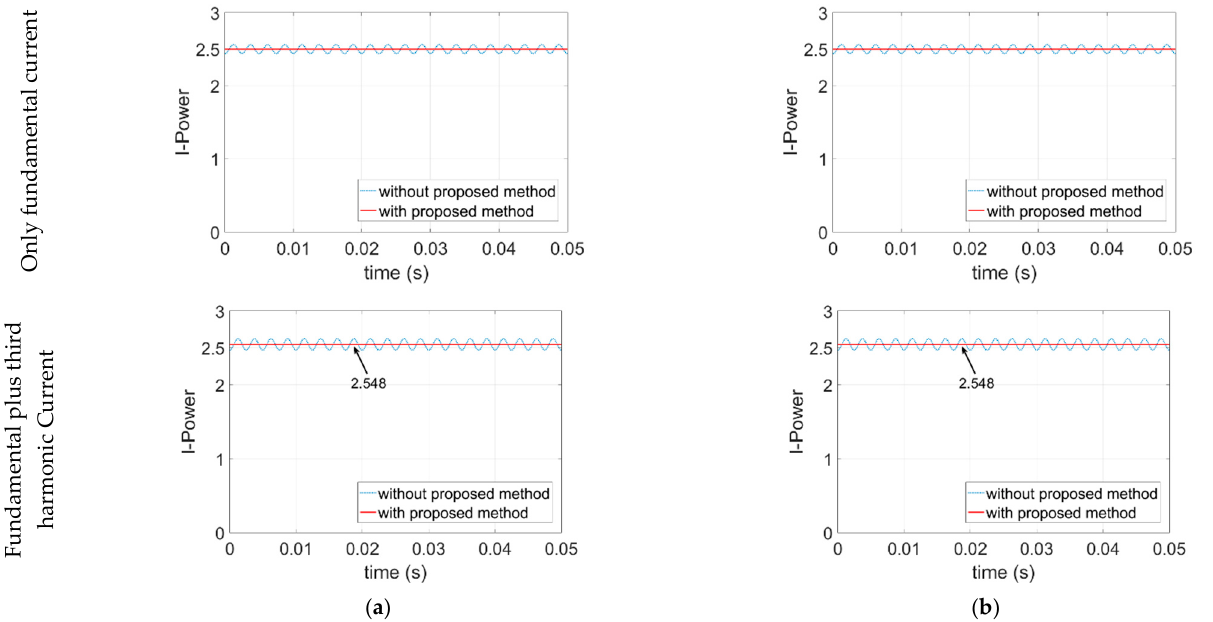
Figure 3. I-power with and without proposed method: ( a ) Considering all the back-EMF harmonics; ( b ) considering the harmonics that cause ripples.